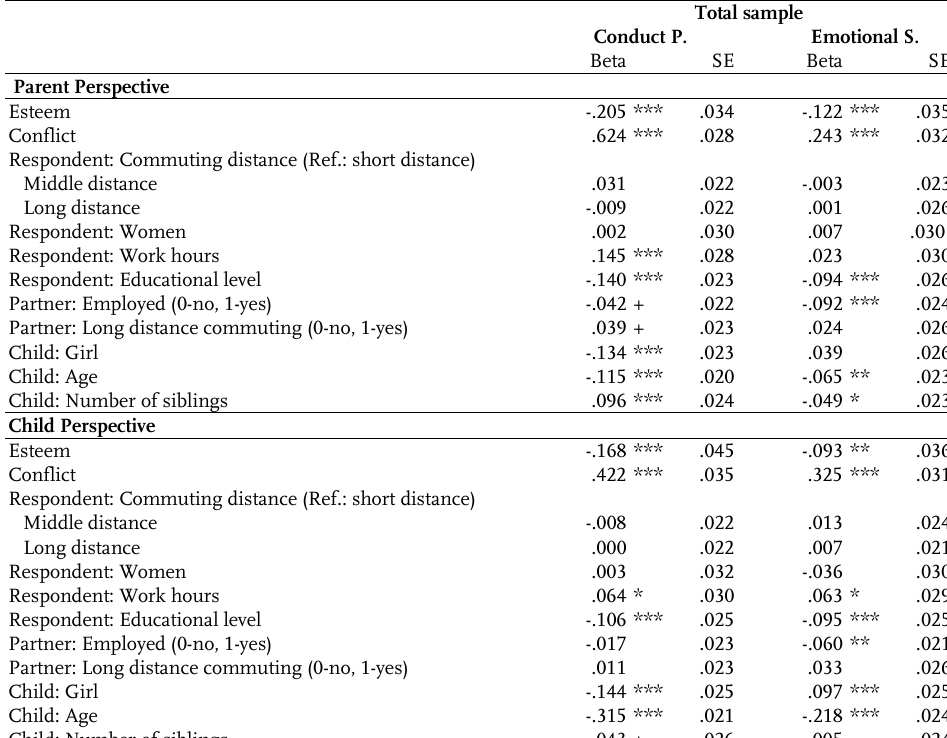
Table 5 : The association between the parent-child relationship (measured by esteem and conflict) and the child’s well-being (measured by conduct problems and emotional